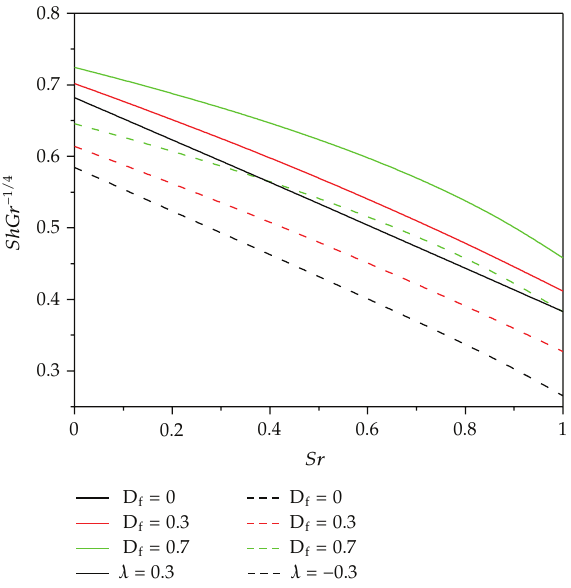
Figure 8: Variation of ShGr − 1 / 4 with Sr for di ff erent values of D f